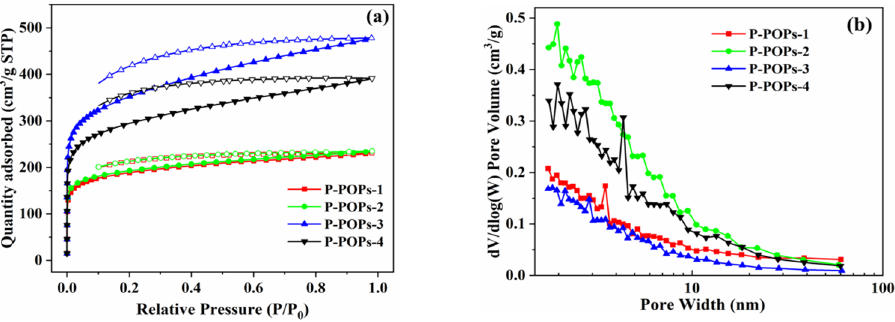
Figure 4. ( a ) N 2 adsorption-desorption isotherms measured at 77 K and ( b ) pore-size distribution curves for P-POPs.